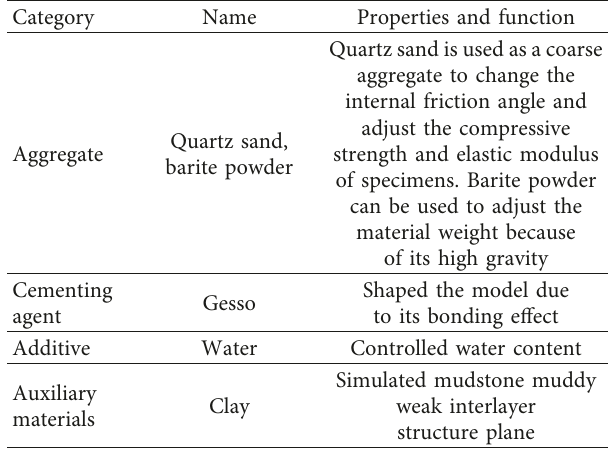
Table 2: The similarity ratios of the test model. Table 3: Types and properties of model